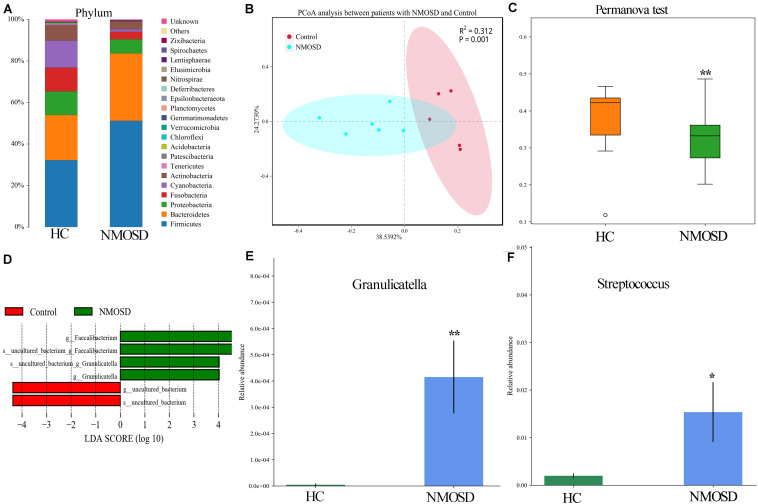
Histogram and scatter diagram showing the distribution characteristics of the intestinal microbiota among the two groups. (A) The distribution characteristics of the intestinal microbiota of the colonic mucosa originated from the same species at the phylum level. (B) The bacterial cluster from HC individuals was significantly distinguished from that of NMOSD patients by PCoA analysis. Each point represents the composition of the intestinal microbiota of one participant. (C) PERMANOVA showed that bacterial diversity was decreased in the NMOSD patients compared to the controls (p = 0.001 < 0.01). (D) LEfSe analysis showed that Granulicatella and Faecalibacterium were dominant in NMOSD specimens (green). (E) The relative abundance of Granulicatella in participants from the two groups (NMOSD vs HC; ∗∗p < 0.01, Metastats analysis). (F) Comparison of the relative abundance of Streptococcus among the two groups (NMOSD vs HC; ∗p < 0.05, Metastats analysis).